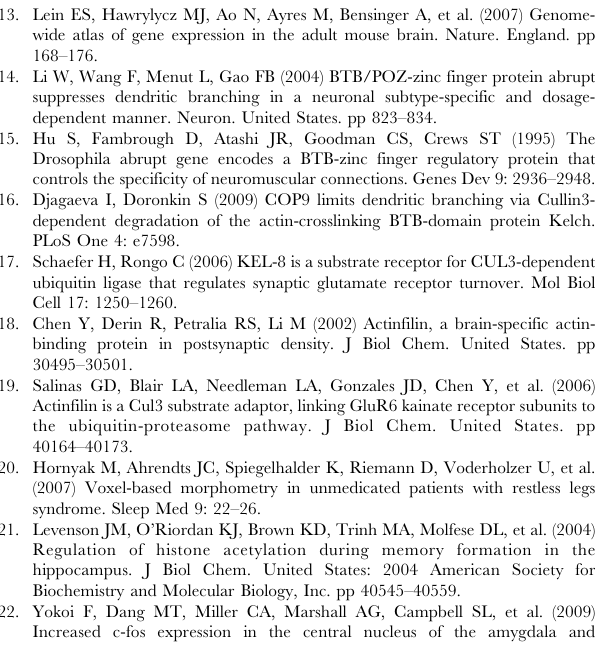
Figure S2 Response to electric shocks. ( A ) Btbd9 mutant